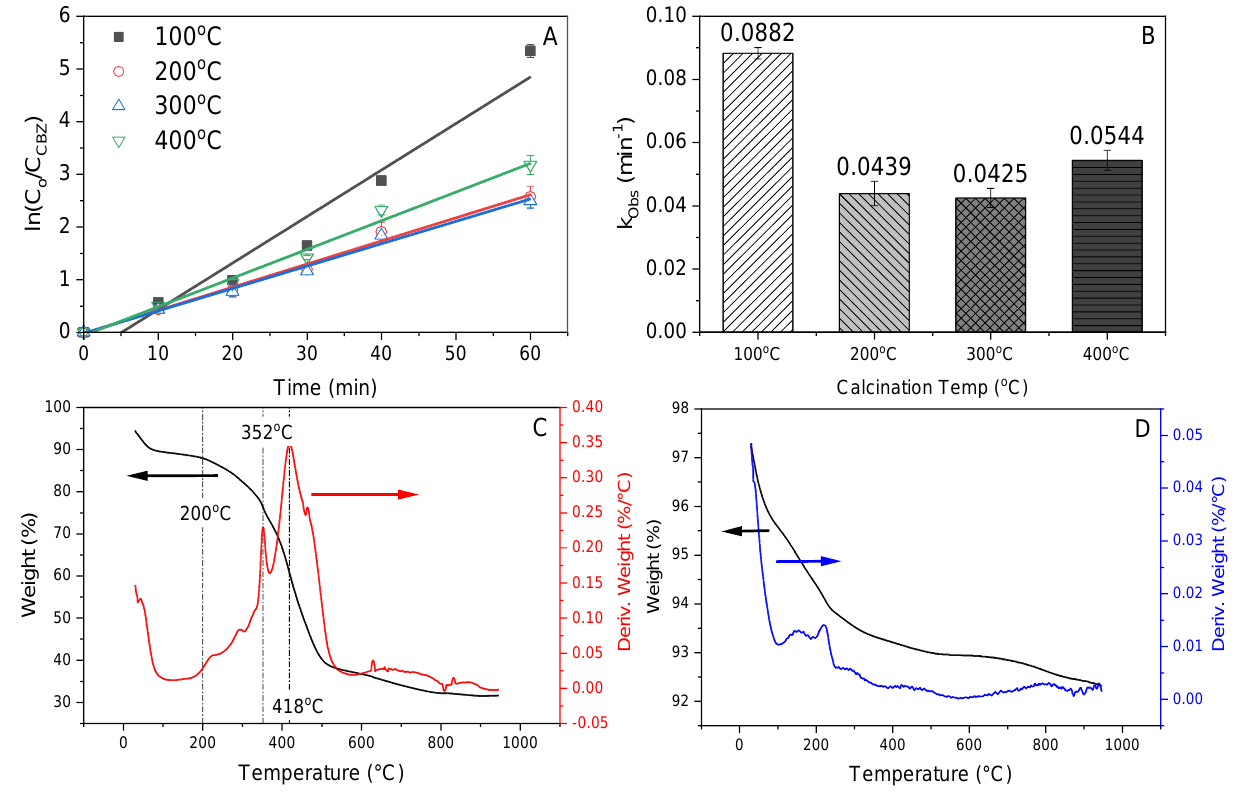
Figure 4. ( A ) ln(C o /C CBZ ) against time at varied temperatures; ( B ) k Obs , min − 1 due to varied calcination temperatures. TGA curves of ( C ) MIL − 101(Cr) and ( D ) anatase TiO 2 under inert conditions (N 2 ).